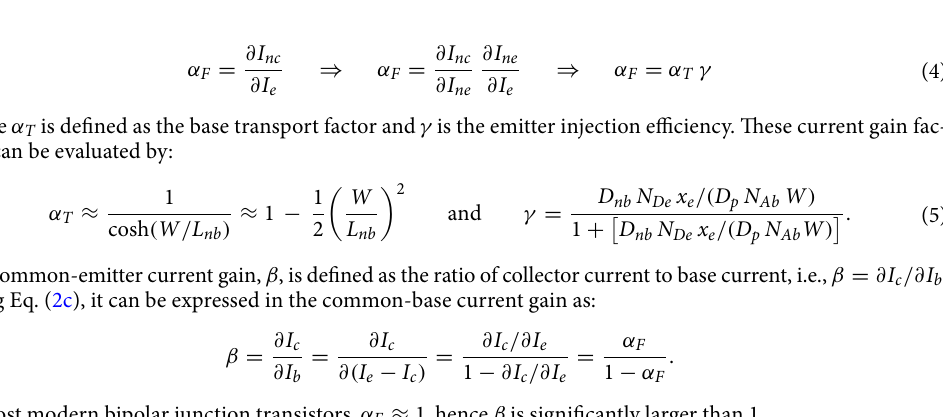
Figure 5. A schematics of a simple amplifier. It is composed of a common-emitter n-p-n bipolar transistor and two resistors. V cc is the power supply hold at a constant positive voltage. V in is the input signal. V out = V ce is the output signal. The V cc , R c , collector, and emitter form an output loop. The V in , R b , base, and emitter form an input